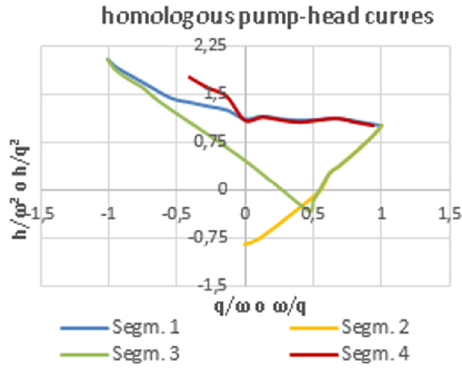
Fig. 4. Homologous pump – head curves.